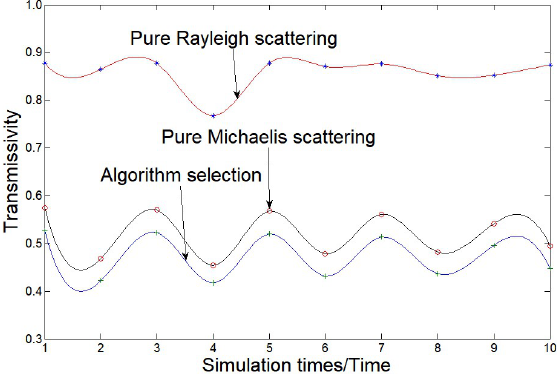
Fig 3 Transmissivity contrast diagram based on scattering classification